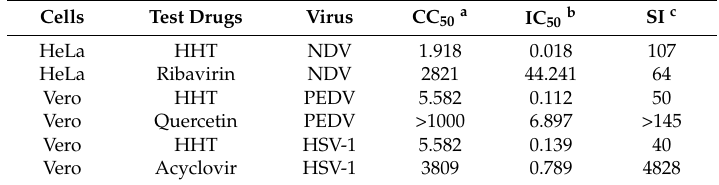
Table 1. Antiviral activity of ribavirin, acyclovir, quercetin, and homoharringtonine (HHT). Cells Test Drugs